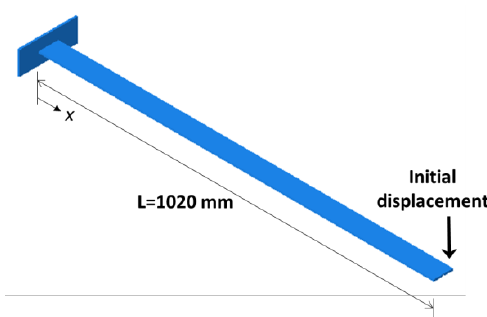
Figure 19. The dimension of cantilever beam.